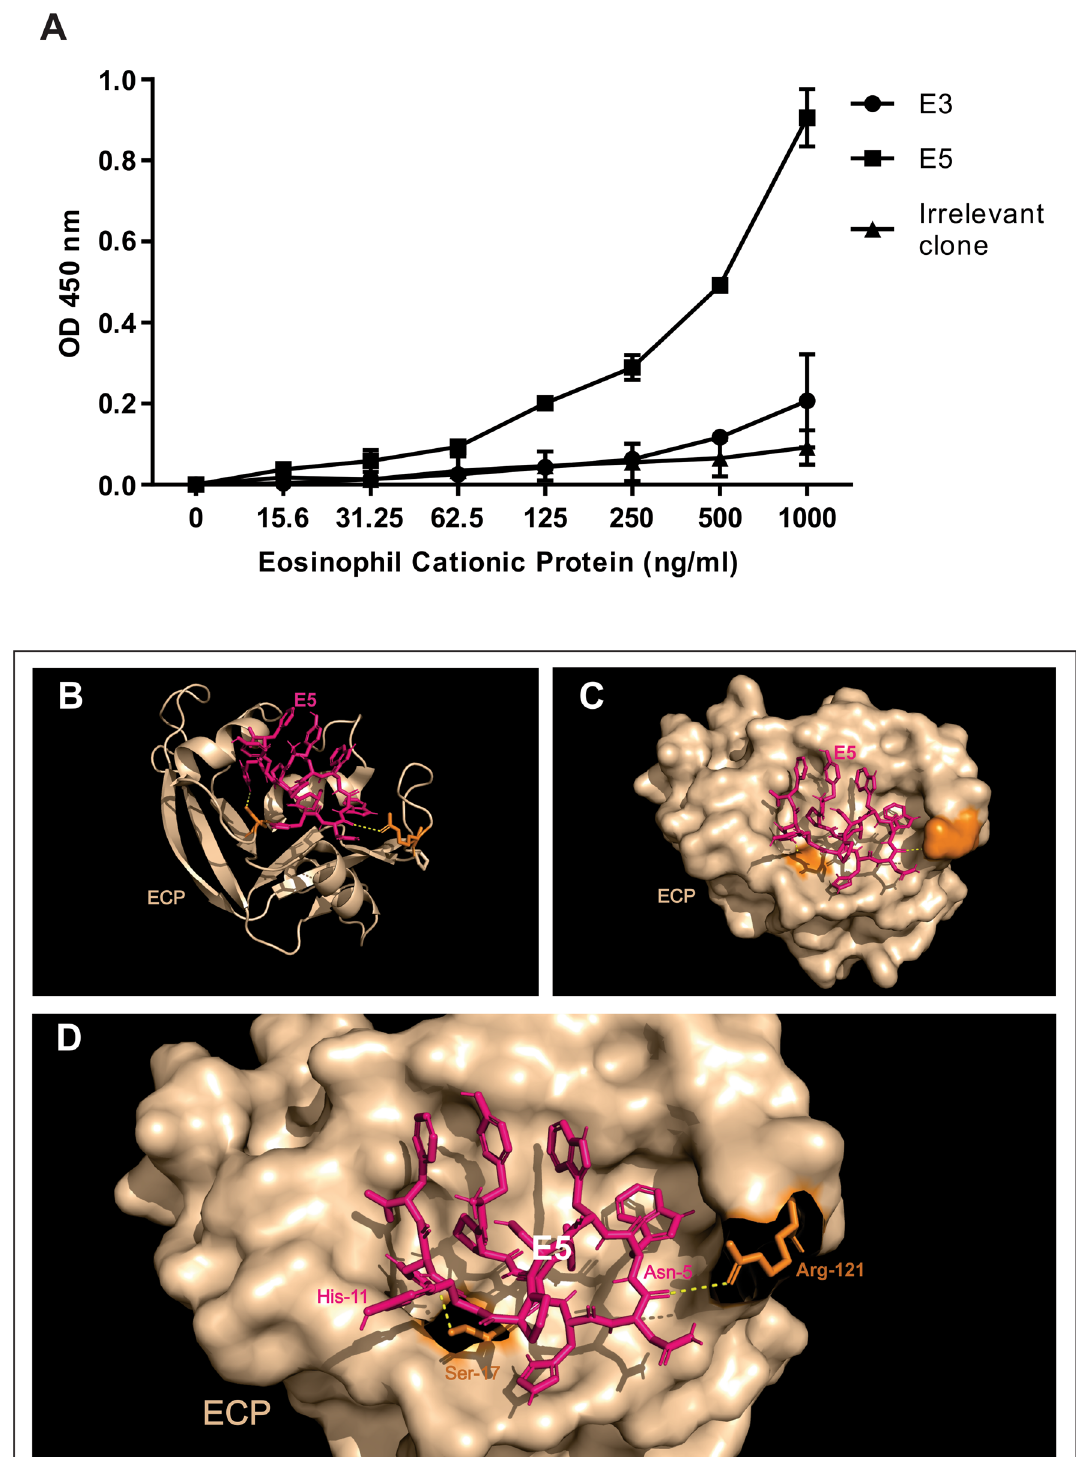
Figure 3. Detection of ECP using Phage-ELISA and molecular docking between the recombinant human Eosinophil Cationic Protein (ECP) and E5 peptide. ( A ) Increasing concentrations of ECP were pre-coated on plates and then incubated with the selected peptides E3, E5 and Irrelevant phage clone and then, incubated with anti-M13 antibody. Antibody was detected by HRP-conjugated anti-IgG and the enzyme substrate. Optical density (OD) was measured at a wavelength of 450 nm. Data represent mean OD ± standard deviation of assays performed in duplicates. ( B ) The full cartoon structure of ECP (wheat) coupled with E5 (hot pink), ( C ) top view of interaction surface topography revealing a binding pocket favoring the best affinity, ( D ) identification of E5 binding residues and interaction sites onto ECP. ECP binding residues are shown in orange. Yellow dashed lines represents polar